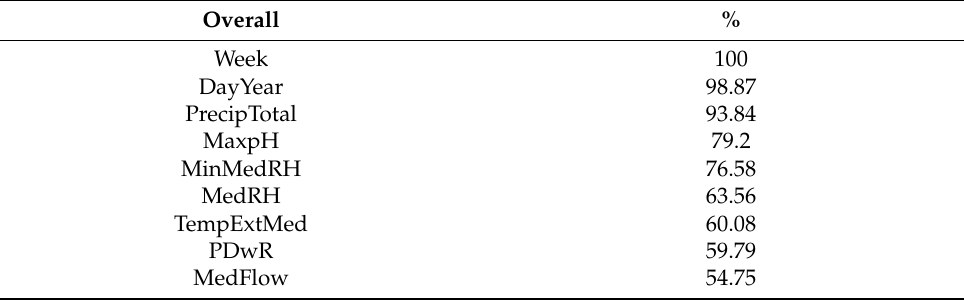
Table 4. Importance of variables in the